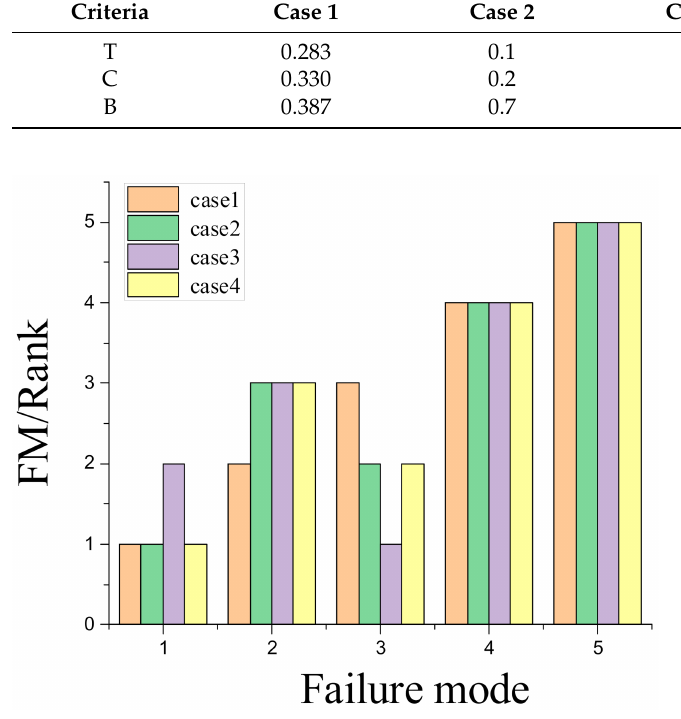
Figure 3. Results of ranking in sensitivity